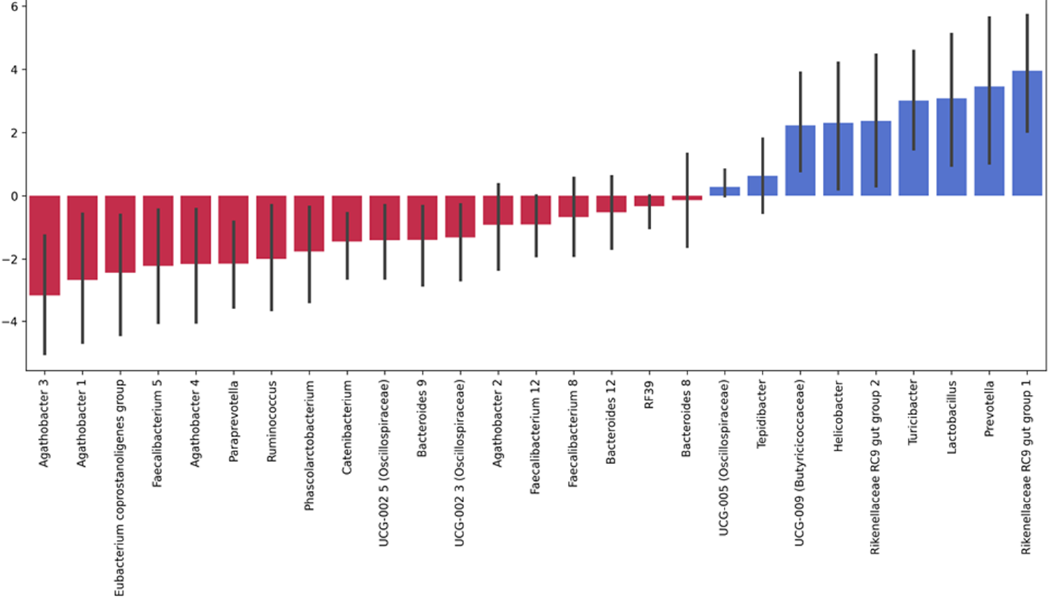
Figure 5. Significant post-TBI changes in the relative abundance of intestinal microorganisms. Note: The height of each bar depicts a fold change in the abundance of a specific microorganism: blue bars show increase and red bars show decrease in post-TBI abundance. Error bars denote CI95% for each change. We calculated the fold change in each microorganism as the mean of its fold changes across all samples before and after the TBI.